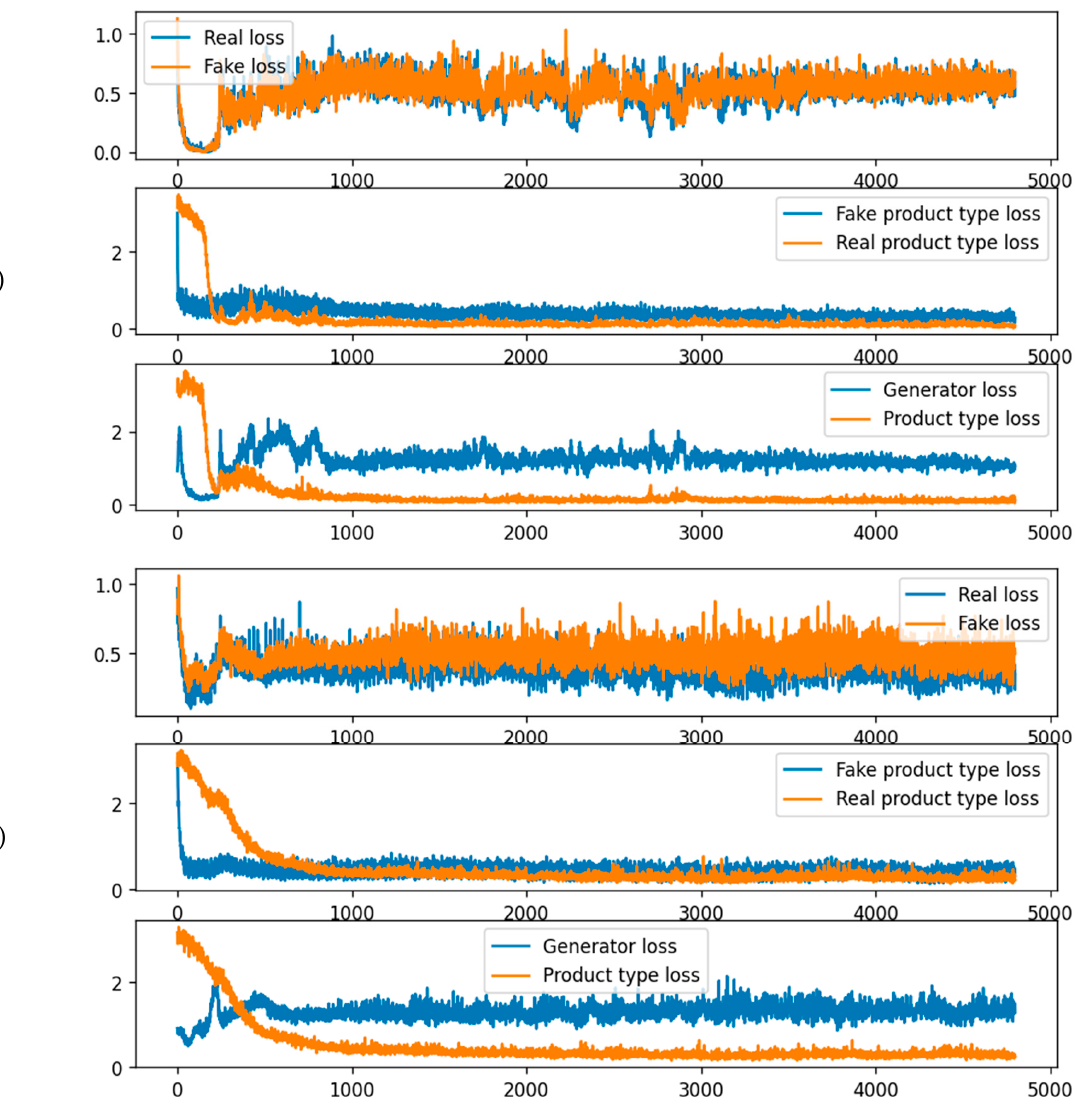
Figure 11. Training loss values of AC ‐ GAN: ( a ) melting process and ( b ) casting process.